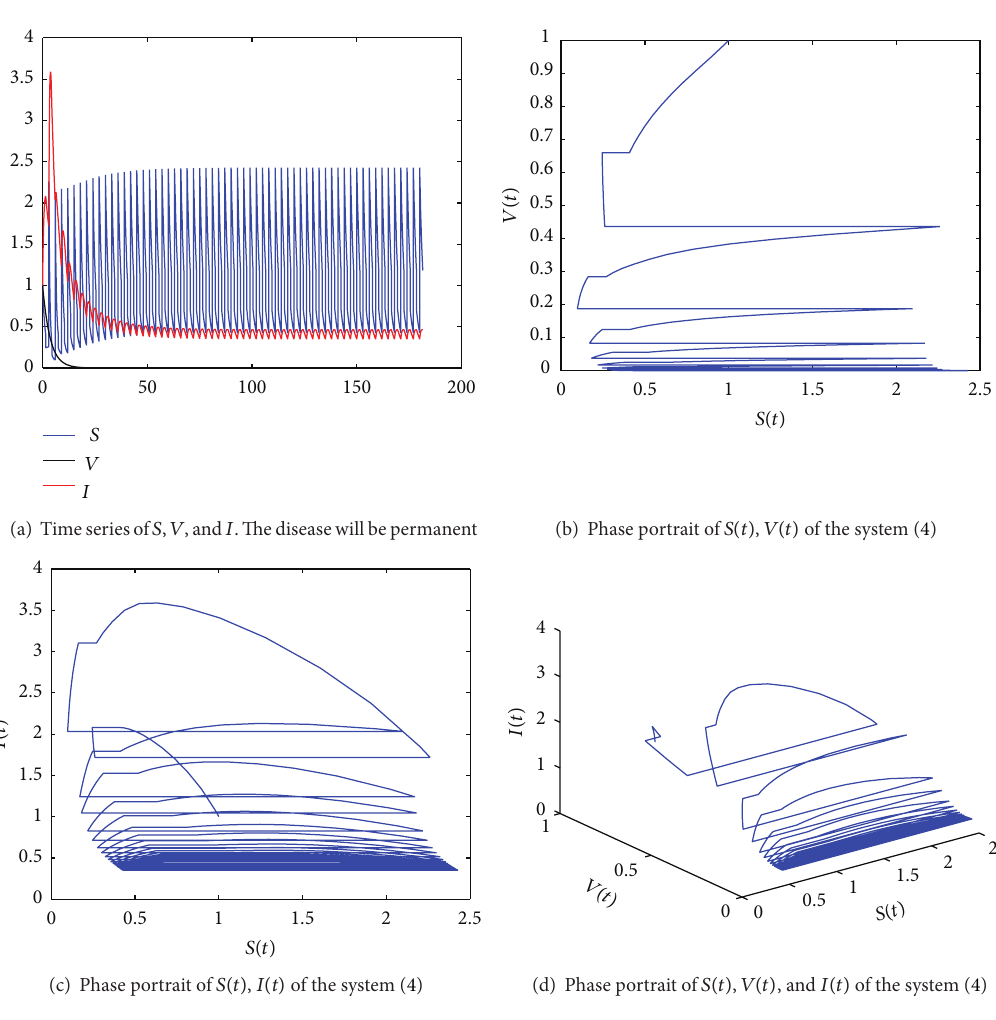
Figure 6: The results of numerical simulation on the threshold values R 2 = 2.3121 > 1 , where 𝑝 = 1.5 , 𝑞 = 1.25 .